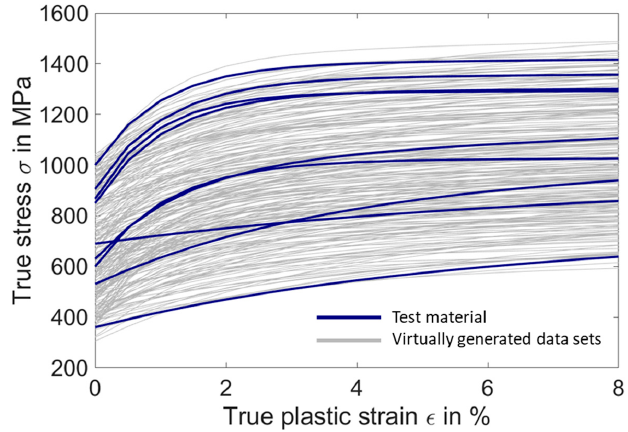
Figure 3. Stress–strain curves from the variation of the material model parameters.